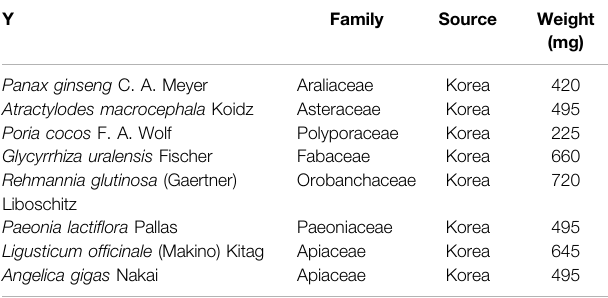
TABLE 1 | Components of Palmul -tang soft extract one